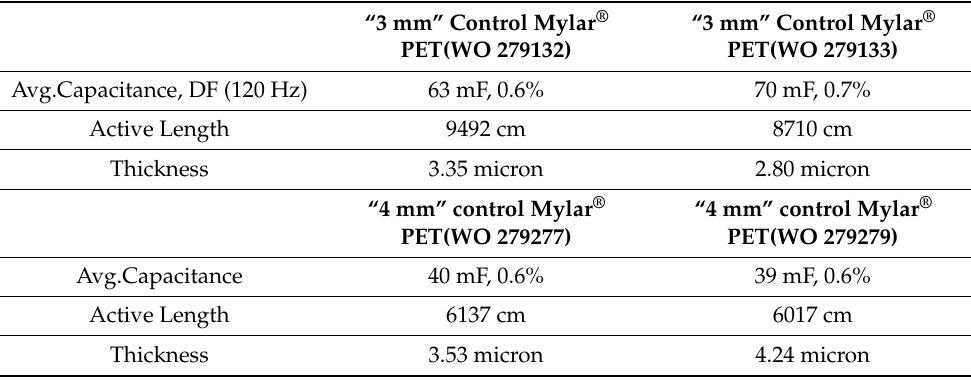
Table 6. Characteristics of the HED film capacitors